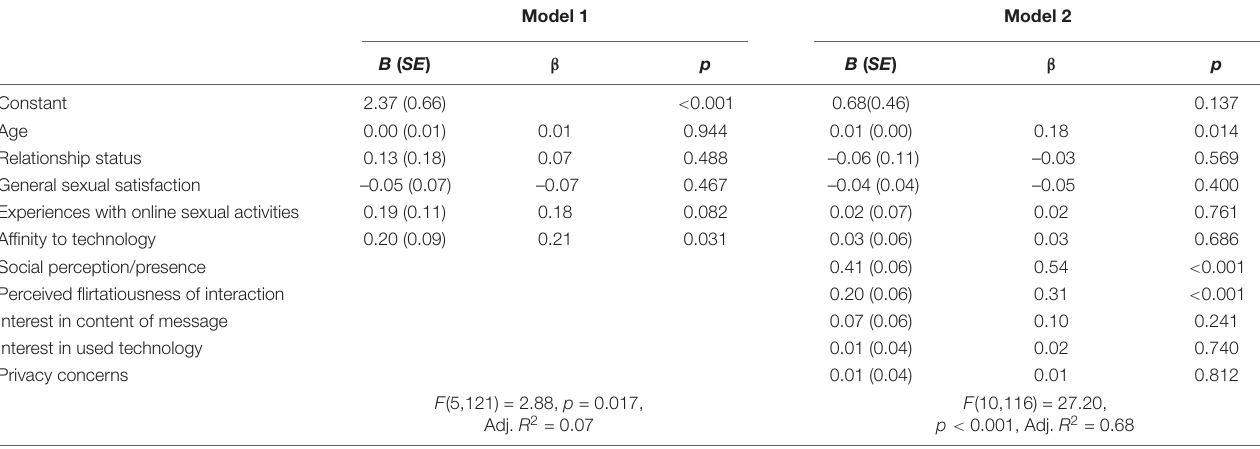
TABLE 3 | Hierarchical regression analysis of the computer-mediated humans perceived sexual